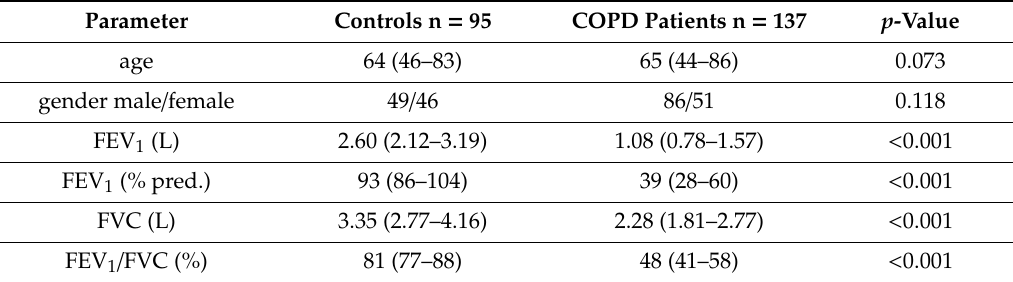
Table 1. Basic characteristics and spirometry parameters of all participants. Age was shown as median with minimum and maximum, and gender as absolute number. All other data were presented as median with interquartile range. Data were tested by Chi-squared or Mann-Whitney